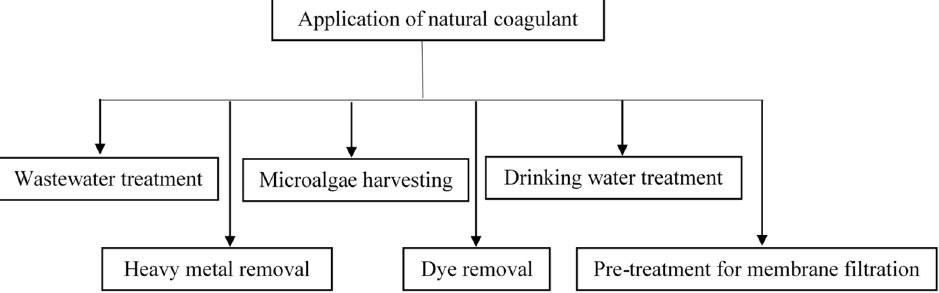
Figure 5. Potential applications of natural coagulants.